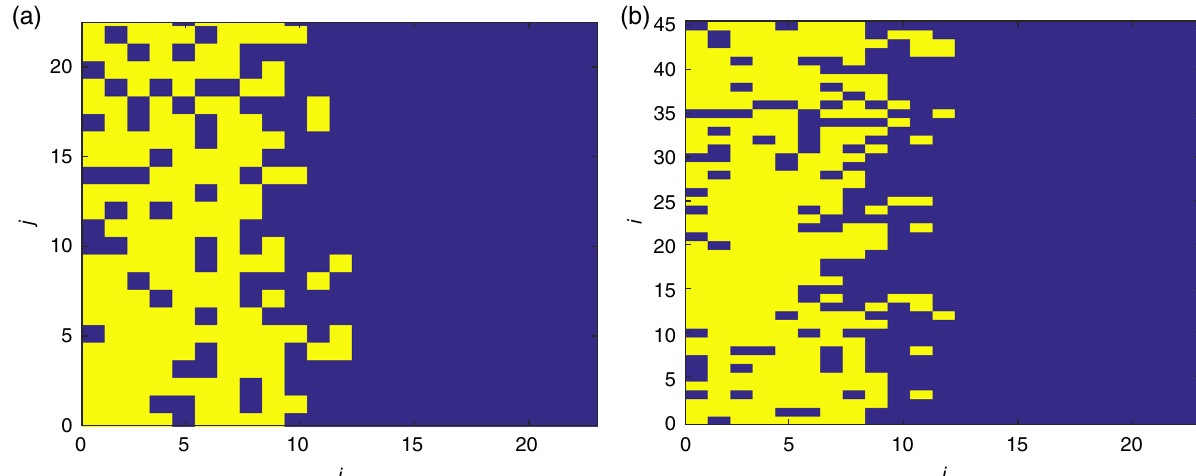
Fig. 5 Increasing the size of the simulation domain while keeping the initial column densities the same. The domain in b is twice the size of that in a , however, the average initial density of each column is the same in both a and